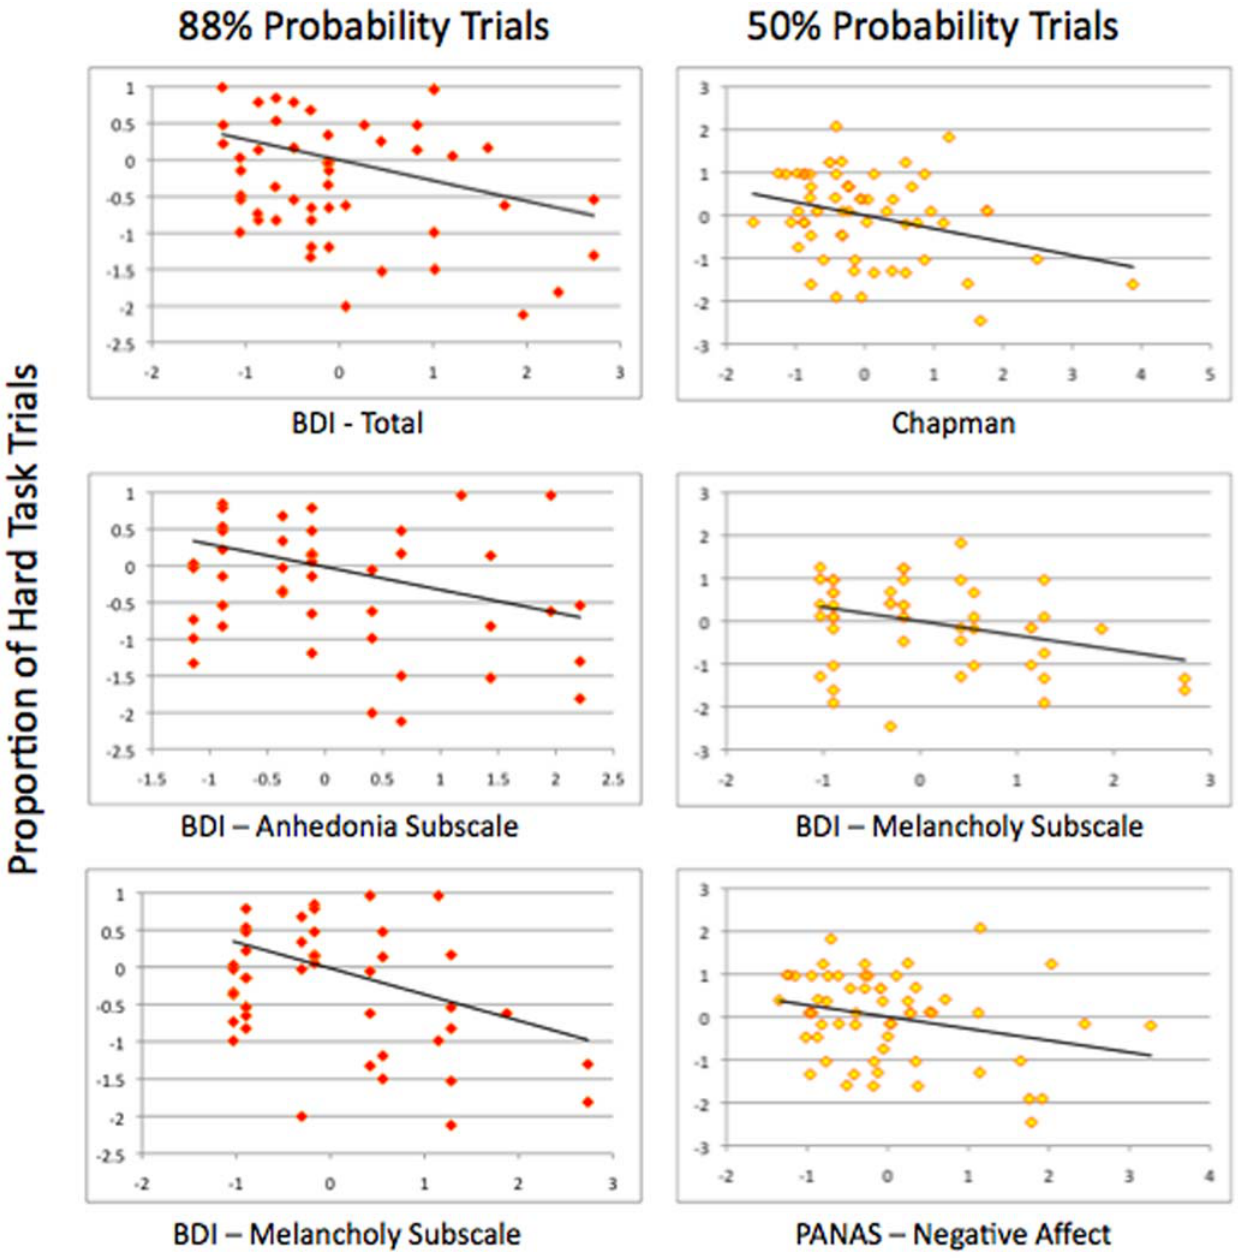
Figure 2. Partial regression plots between measures of anhedonia and proportion of hard-task choices, controlling for gender. doi:10.1371/journal.pone.0006598.g002 between win/no-win feedback and trait anhedonia ( b =.01, p , .001), reflecting a greater influence of reward feedback on decision-making for individuals with higher levels of anhedonia.